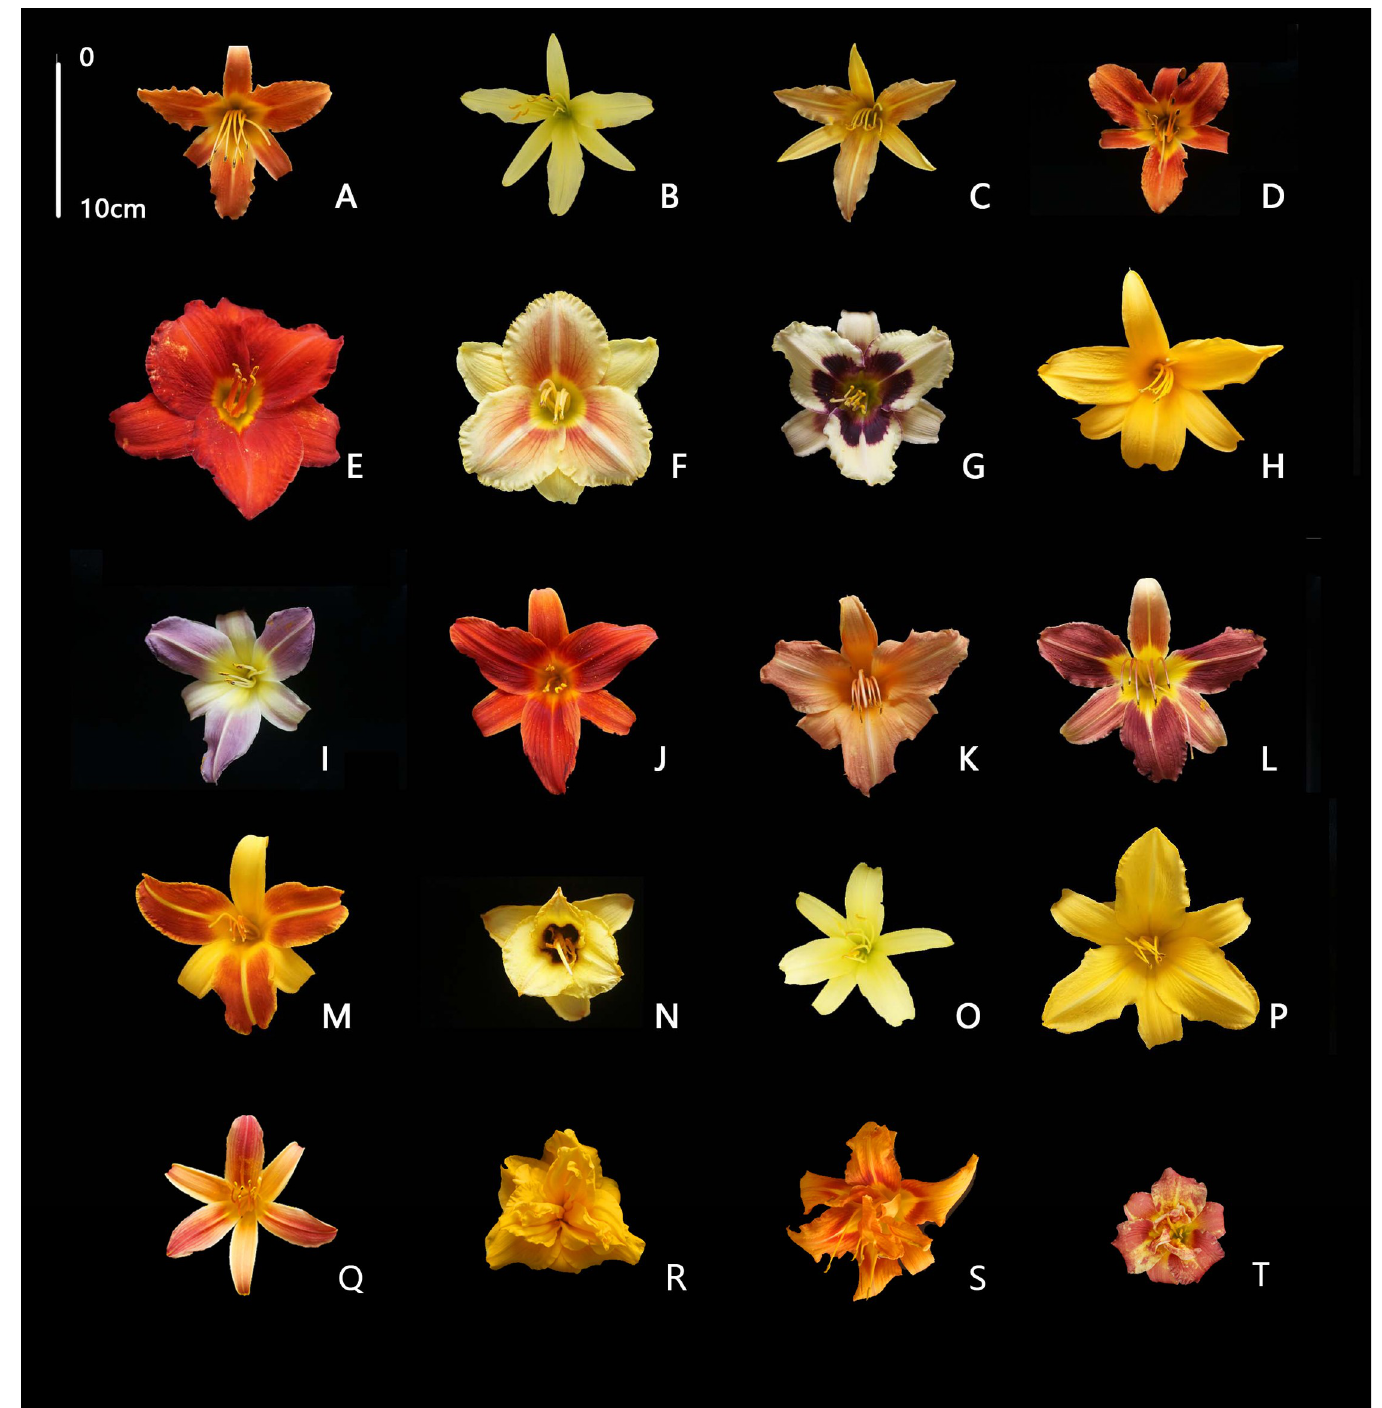
Fig 3. The phenotypic diversity of daylily cultivars flower colors. Note: The cultivars photographed under indoor illumination, are identified as follows: A: ‘Suqian 1-H’, B: ‘ChaZi Hua’, C: ‘Panlong Hua’, D: ‘Suqian 3-C’, E: ‘Apache’, F: ‘Truth’, G: ‘Moon Masquerade’, H: ‘Nakai’, I: ‘Blue Sheen’, J: ‘XiaoHong’, K: ‘Children’s Festival’, L: ‘Elegant Greeting’, M: ‘Frans Hals’, N: ‘Little Bee’, O: ‘Da Wuzui’, P: ‘Ruffled Apricot’, Q:‘Y-326’, R:‘Cream Roll’, S:‘Beijing 1’, T:‘Little Red Baron’.